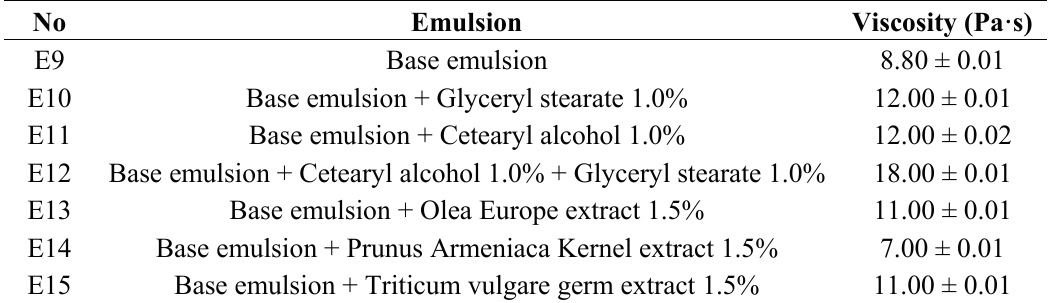
Table 7. Viscosity values of emulsions containing consistency factors and vegetable waxes.